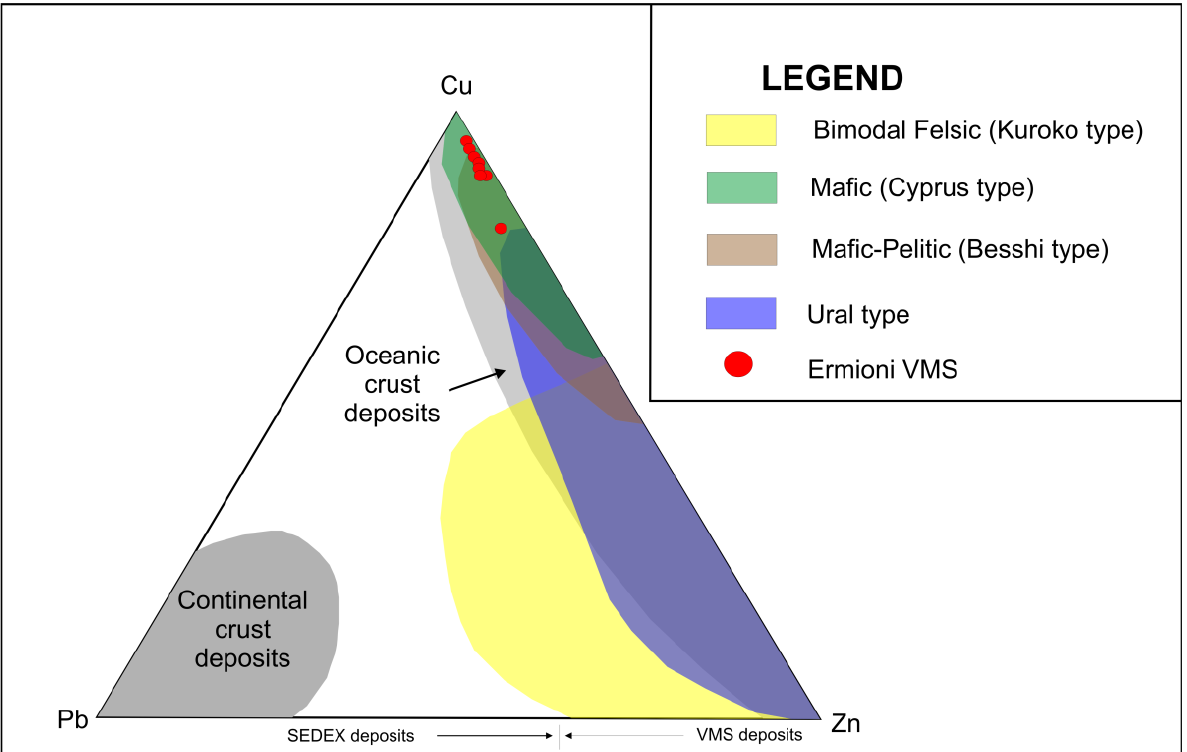
Figure 2. Cu-Pb-Zn ternary diagram of the base-metal composition of various VMS deposit types (data after [4,19]). Red circles depict the massive ore geochemistry of Ermioni mafic–pelitic VMS, plotted in the field of “Cyprus-type” deposits.